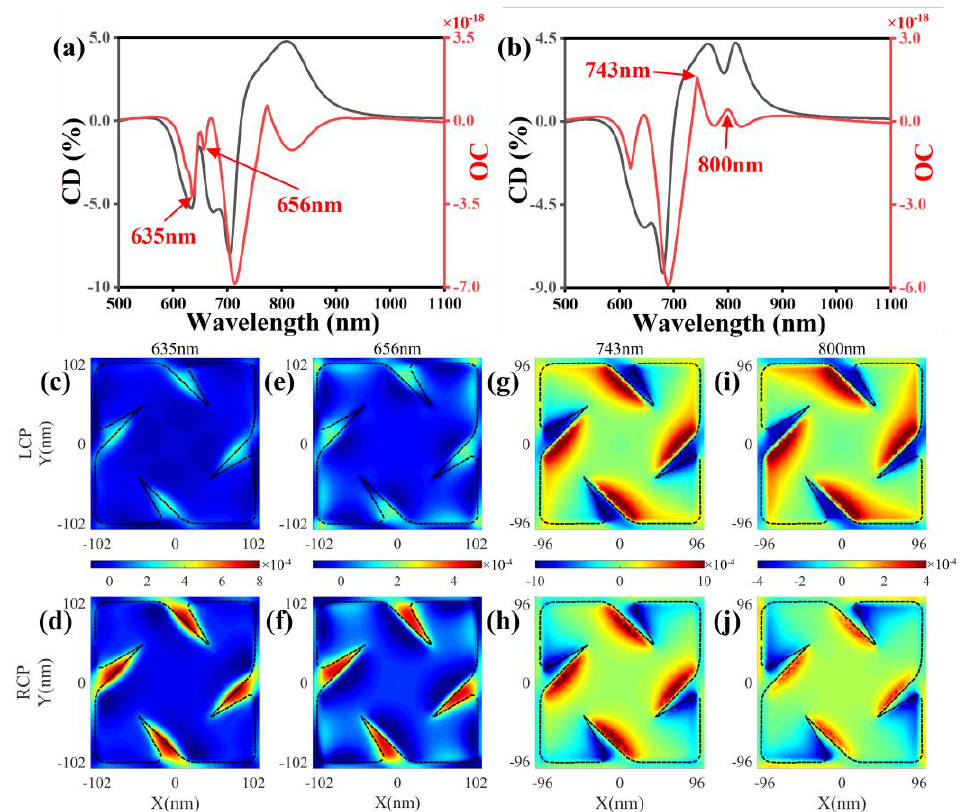
Figure 6. ( a ) CD spectra (black line) and OC integral spectra (red line) of the vertex mode–excitons strong coupling system when side length l = 205 nm. ( b ) CD spectra (black line) and OC integral spectra (red line) of the mixed mode–excitons strong coupling system when side length l = 192 nm. The red arrows mark out positions of two energy branches. ( c – j ) The OC distribution on integral surface at resonance positions of UPB and LPB in vertex mode–excitons (635 nm, 656 nm) and mixed mode–excitons (743 nm, 800 nm) strong coupling system. Top panels and bottom panels indicate LCP and RCP incidence, respectively.